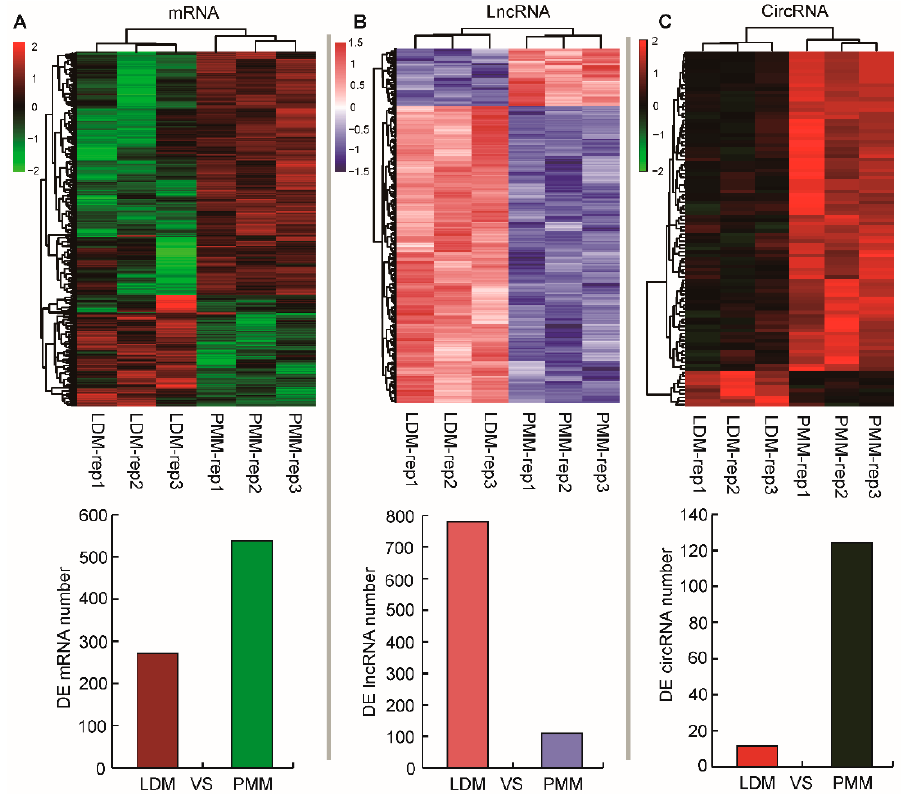
Figure 4. Hierarchical clustering analysis for differentially expressed (DE) mRNAs ( A ), lncRNAs ( B ), and circRNAs ( C ) between LDM and PMM.